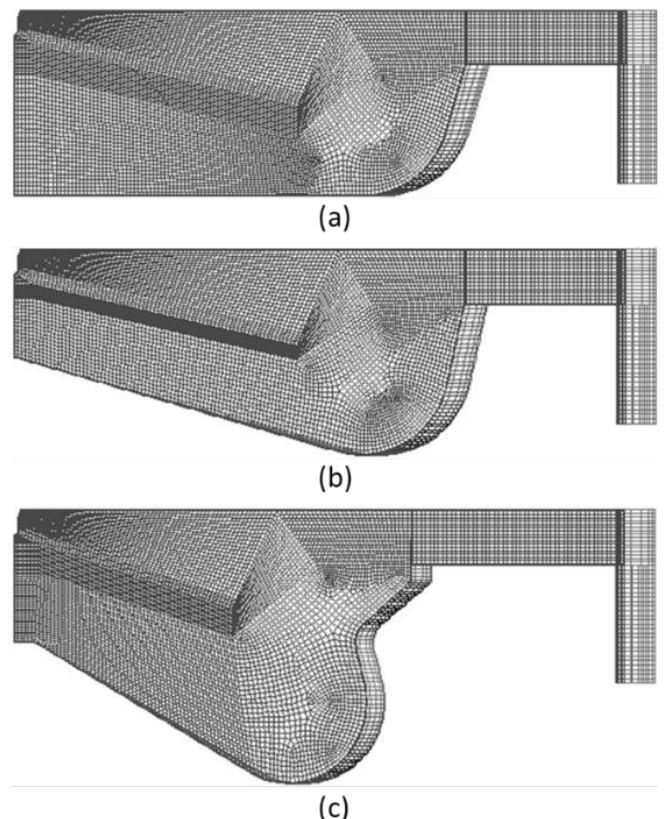
Figure 2. 3D computational meshes of ( a ) U-type, ( b ) ω -type, ( c ) re-entrant type combustion chambers at the TDC of the engine.